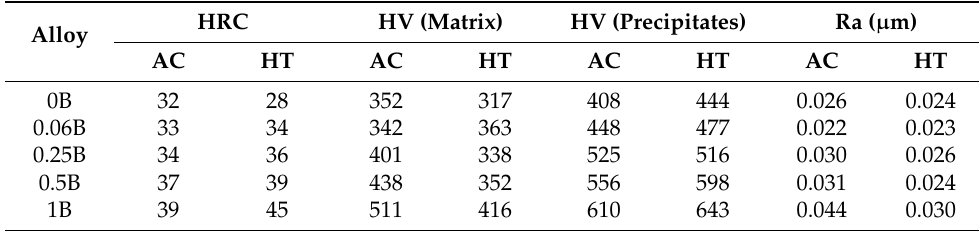
Table 4. Hardness, microhardness and roughness of